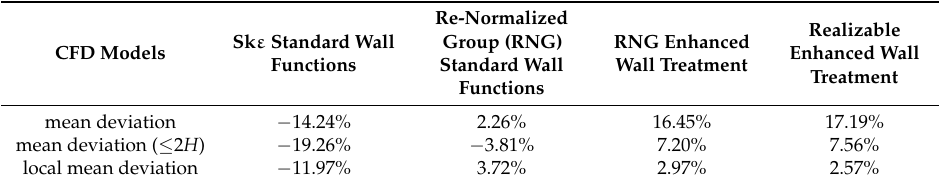
Table 3. CFD turbulent model accuracy.